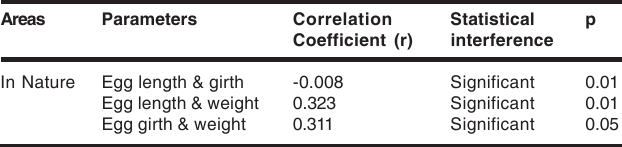
Table 1. Material used in nest construction Major plant species Capsicum frutescens